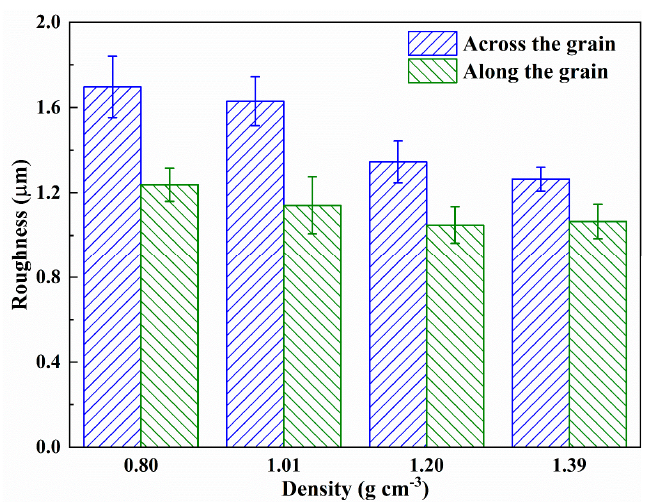
Figure 4. Surface roughness of scrimbers at different densities.